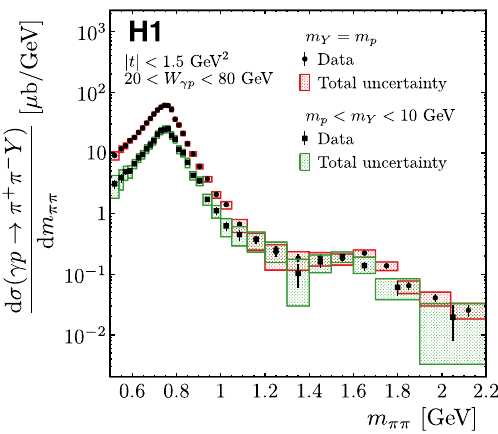
Fig. 6 Elastic ( m Y = m p ) and proton-dissociative ( m p < m Y < 10 GeV) differential π + π − photoproduction cross and error bars show the measured cross section values with statistical uncertainties. The red and green bands show the total uncertainties of the elastic and proton-dissociative components,